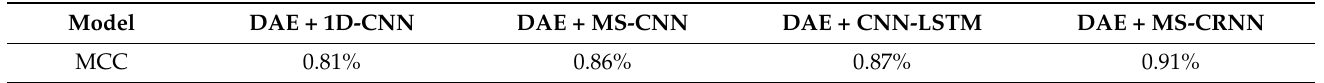
Table 8. Results of the MCC under the denoising condition.